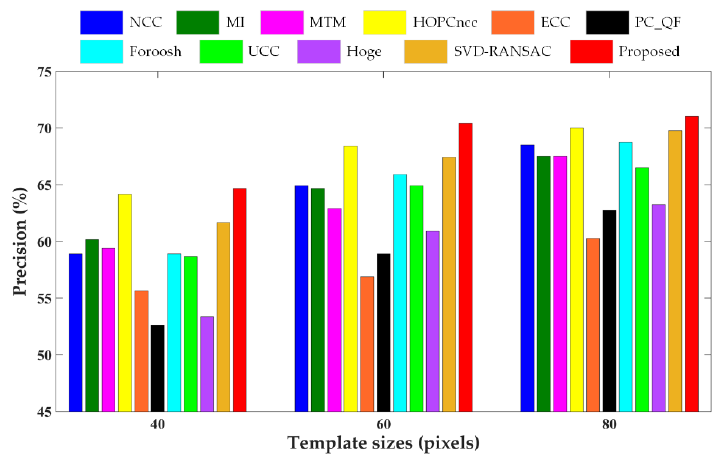
Figure 4. Precision values of different methods for Data 1. NCC, normalized cross correlation; MI, mutual information; MTM, matching by tone matching; HOPCncc, NCC of the HOPC descriptors; ECC, enhanced correlation coefficient; PC_QF, PC with quadratic fitting; UCC, upsampled cross correlation; SVD-RANSAC, singular value decomposition-random sample consensus.